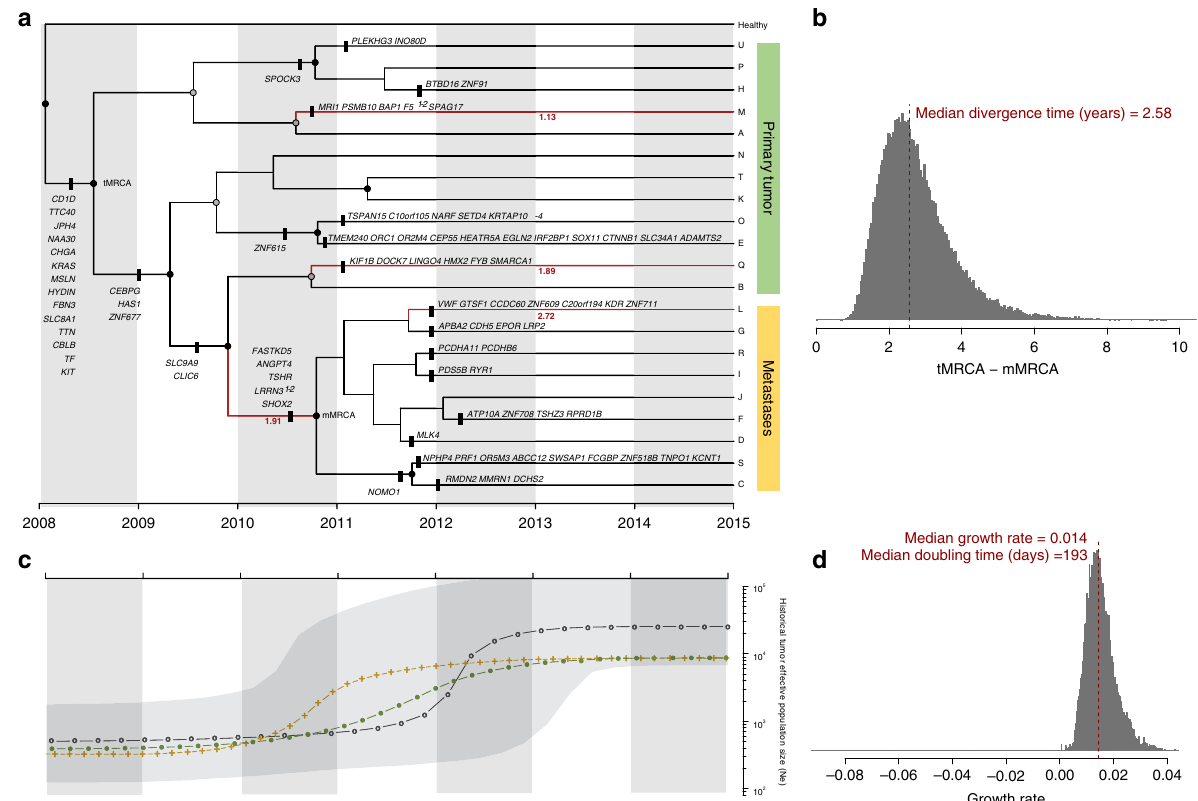
Fig. 2 Phylogenetic and demographic reconstruction over time. a Maximum clade credibility (MCC) tree resulting from the BEAST analyses using the CloneFinder-derived clones. Tree nodes with posterior probability values >0.99 and >0.50 are indicated with black and gray solid circles, respectively. Clone IDs (A – U) are shown at the tips of the tree. The x -axis is scaled to years (assuming one generation every 4 days; see Methods). Only non- synonymous mutations are shown. Tree branches showing a d N /d S ratio >1 are highlighted in red together with the corresponding d N /d S value. b Posterior probability distribution of the relative divergence time in years of mMRCA in relation to the tMRCA (tMRCA minus mMRCA). The dashed red line depicts the median age estimate of the mMRCA. c Bayesian Skyline Plot analysis. The y -axis is in log scale. The black dotted line represents the historical effective population size of the entire cancer cell population (Ne). The gray shading illustrates the 95% HPD interval. Green and golden dotted lines correspond to the effective population sizes of the primary and metastatic populations, respectively. d Histogram illustrating the growth rate per generation of the tumor. The population doubling time is shown in